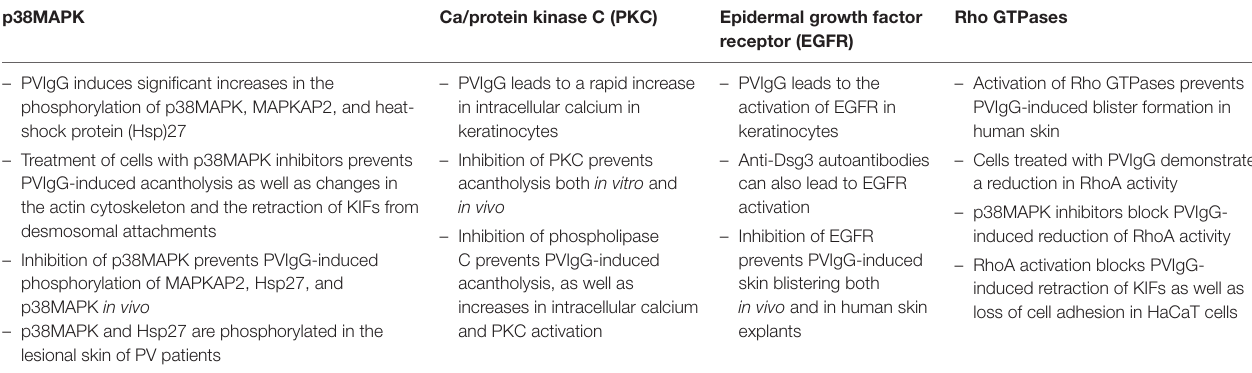
TABLe 2 | Evidence in support of pemphigus vulgaris (PV)-associated signaling pathways.